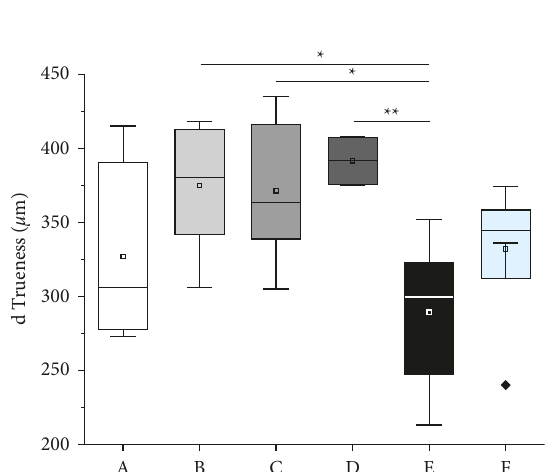
Figure 6: Boxplots of trueness for angle ( θ ).